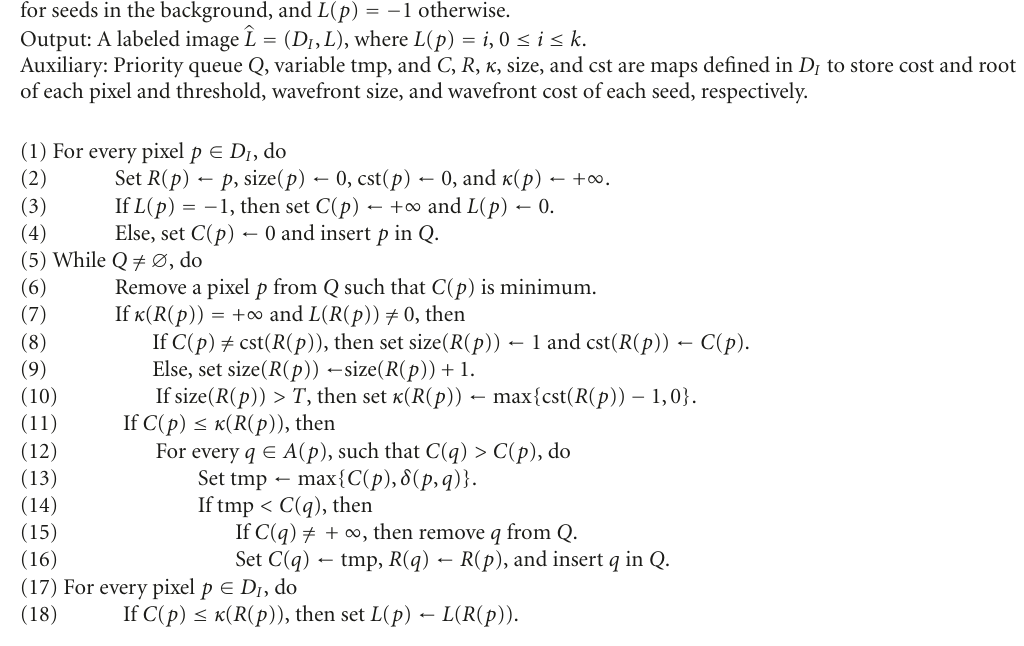
Algorithm 2: Multiple object definition with seed competition. algorithm stops propagation when the value κ s of a seed s is found. In the case of seed competition, the root map is used to find in constant time the root of each pixel in S . The influence zone of a seed s ∈ S is limited either when it